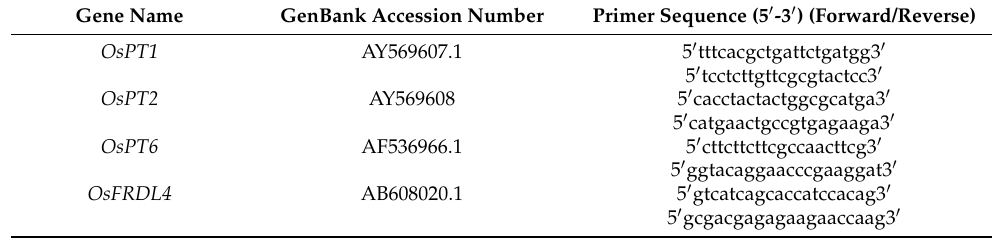
Table 1. Candidate reference rice ( Oryza sativa L.) genes and primers derived from RT-qPCR analysis. Gene